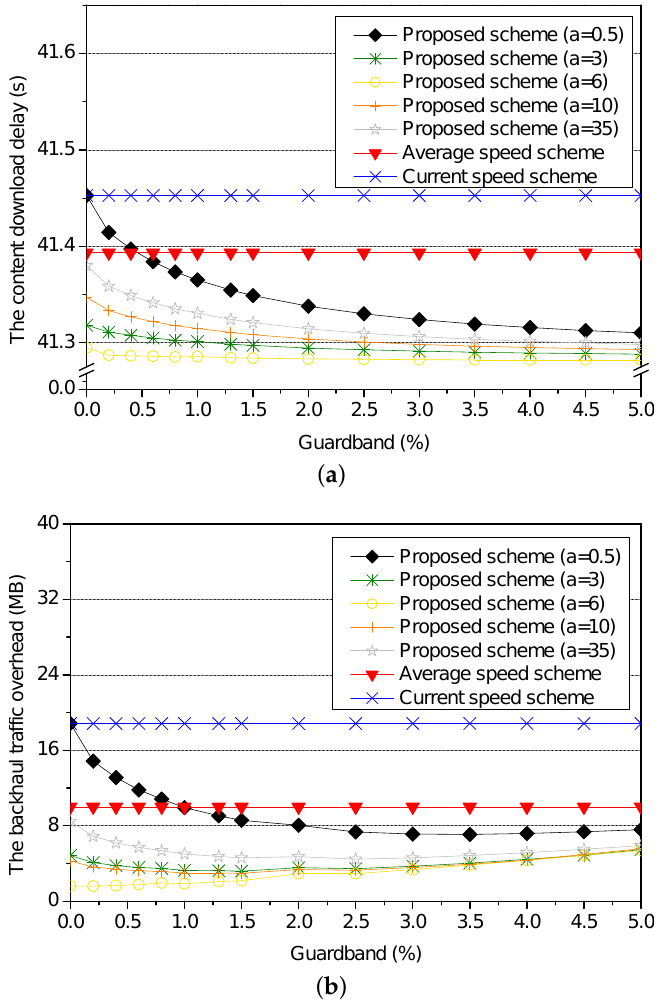
Figure 10. Simulation results for different sizes of the guardband: ( a ) the content download delay and ( b ) the backhaul traffic